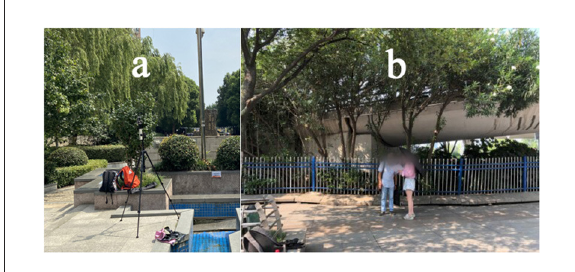
FIGURE3 Temperature measurement and questionnaire [ (a) handheld weather meter setup; (b) questionnaire distribution].